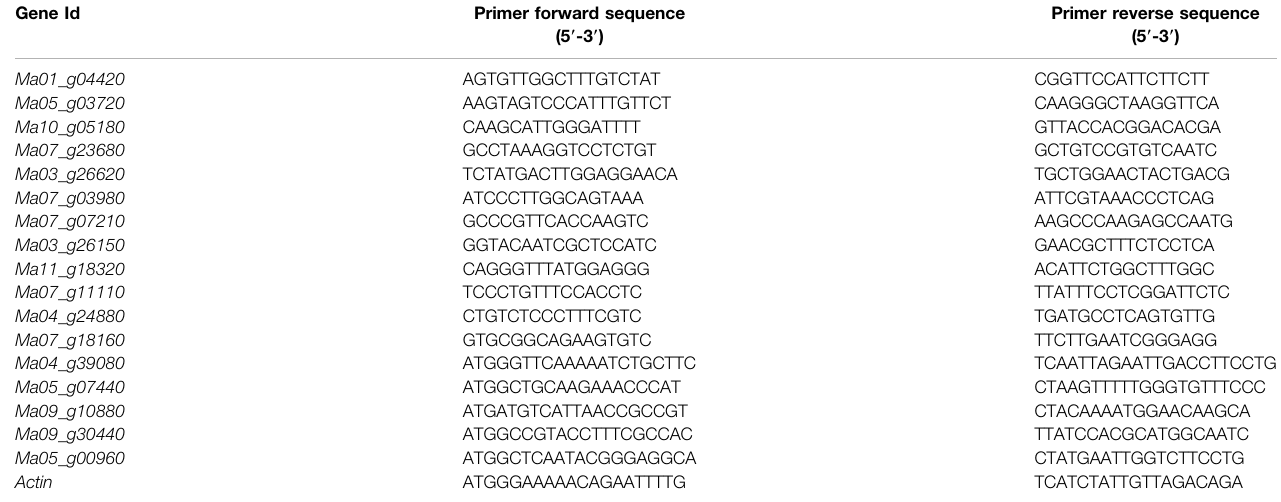
TABLE 2 | List of primers used for qRT-PCR analysis of selected genes in M. nana peel treated with or without UV-C. Gene